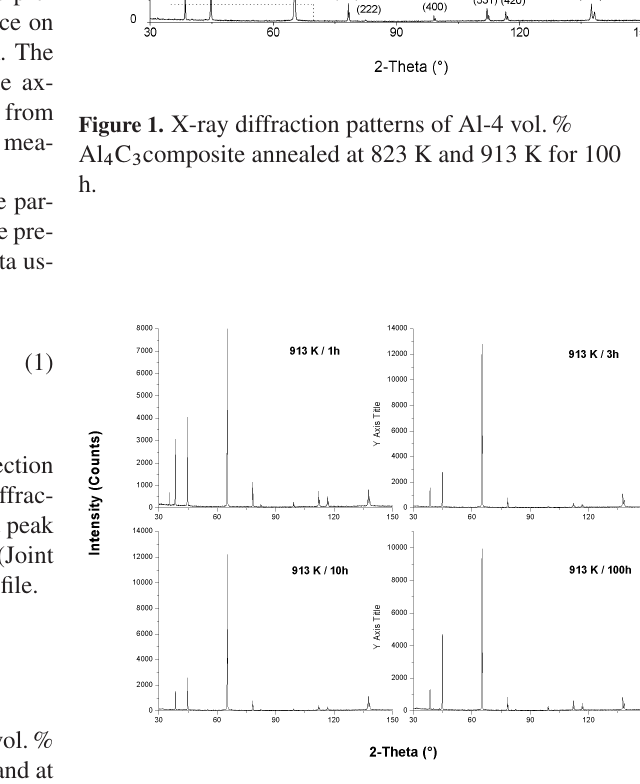
Figure 2. X-ray diffraction patterns of Al-4 vol. % Al 4 C 3 material annealed in dependence on times (1 h, 3 h, 10 h and 100 h) at 913